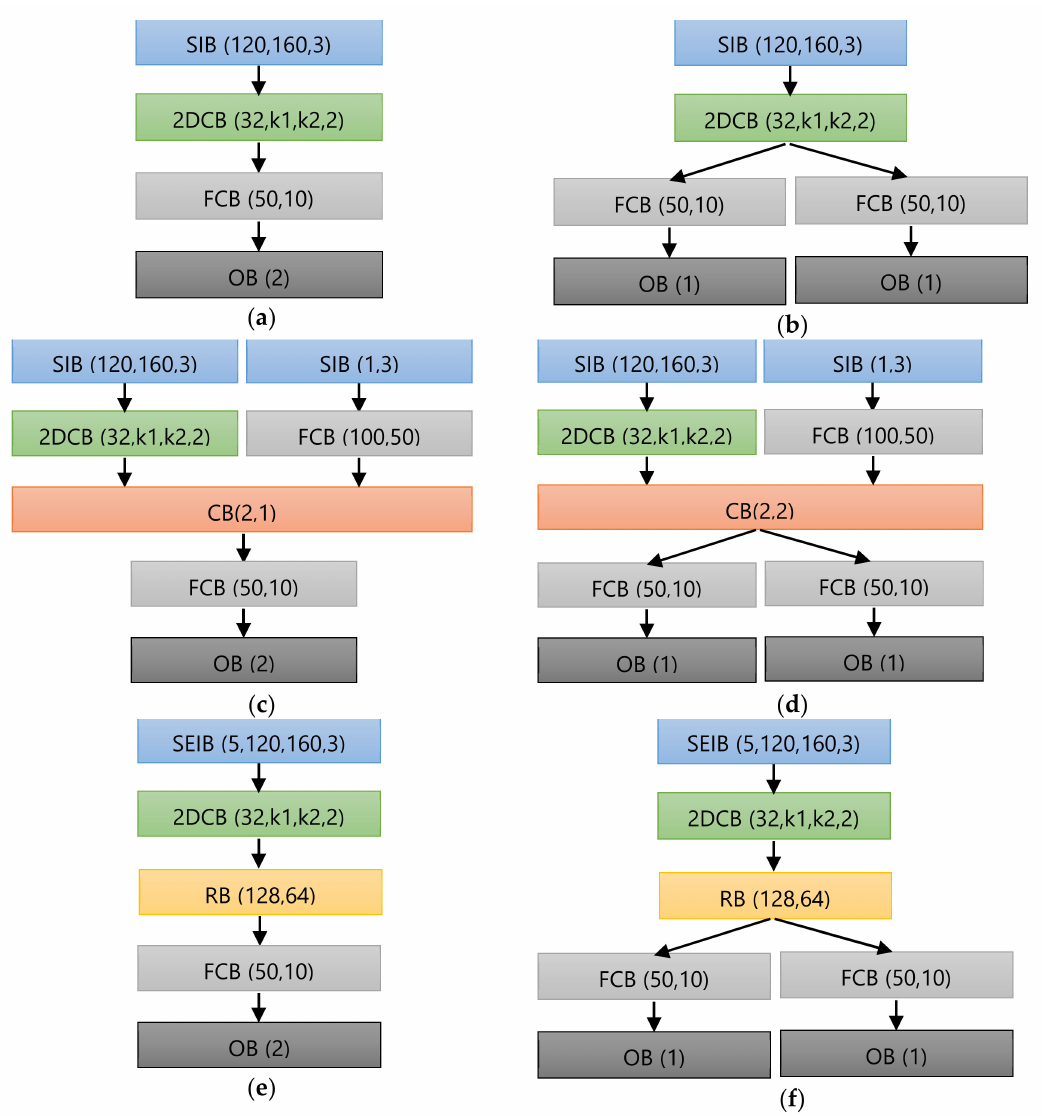
Figure 9. Type 1 and type 2 e2e architectures. ( a ) SiD1; ( b ) SiD2; ( c ) MiD1; ( d ) MiD2; ( e ) SeD1; ( f )